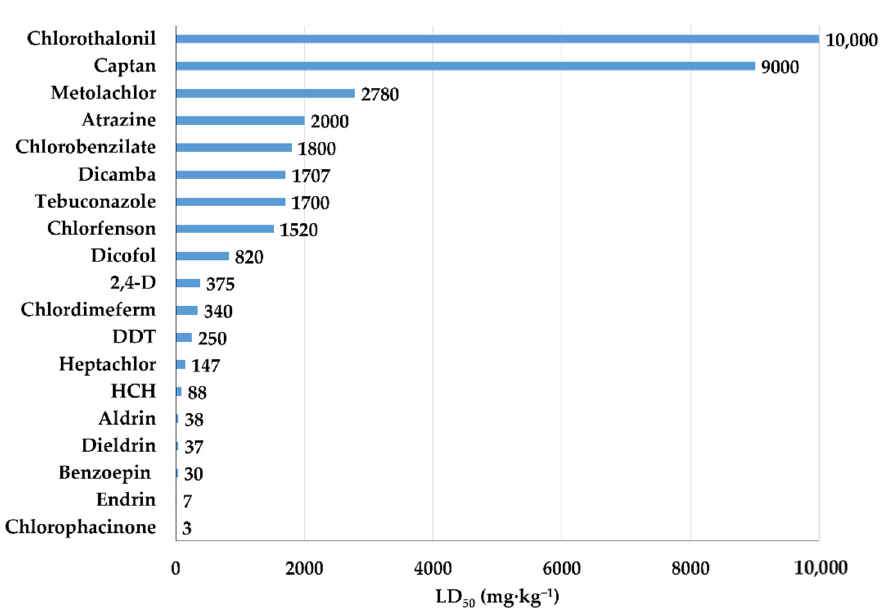
Figure 5. LD 50 (mg · kg − 1 ) of organochlorines for the